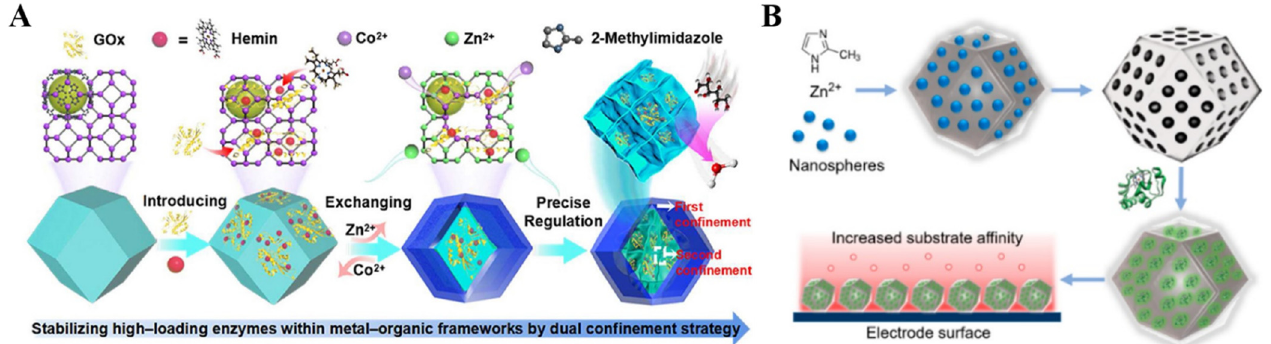
Figure 4. ( A ) Schematic illustration of the synthetic route of GOx/Hemin@NC − ZIF. Reprinted with permission from Ref. [164]. Copyright 2022, American Chemical Society. ( B ) Schematic illustration of the synthesis of Cyt c@mesoZIF-8 and the detection of H 2 O 2 with a Cyt c@mesoZIF-8/screen-printed electrode (SPE). Reprinted with permission from Ref. [170]. Copyright 2017, American Chemical Society.